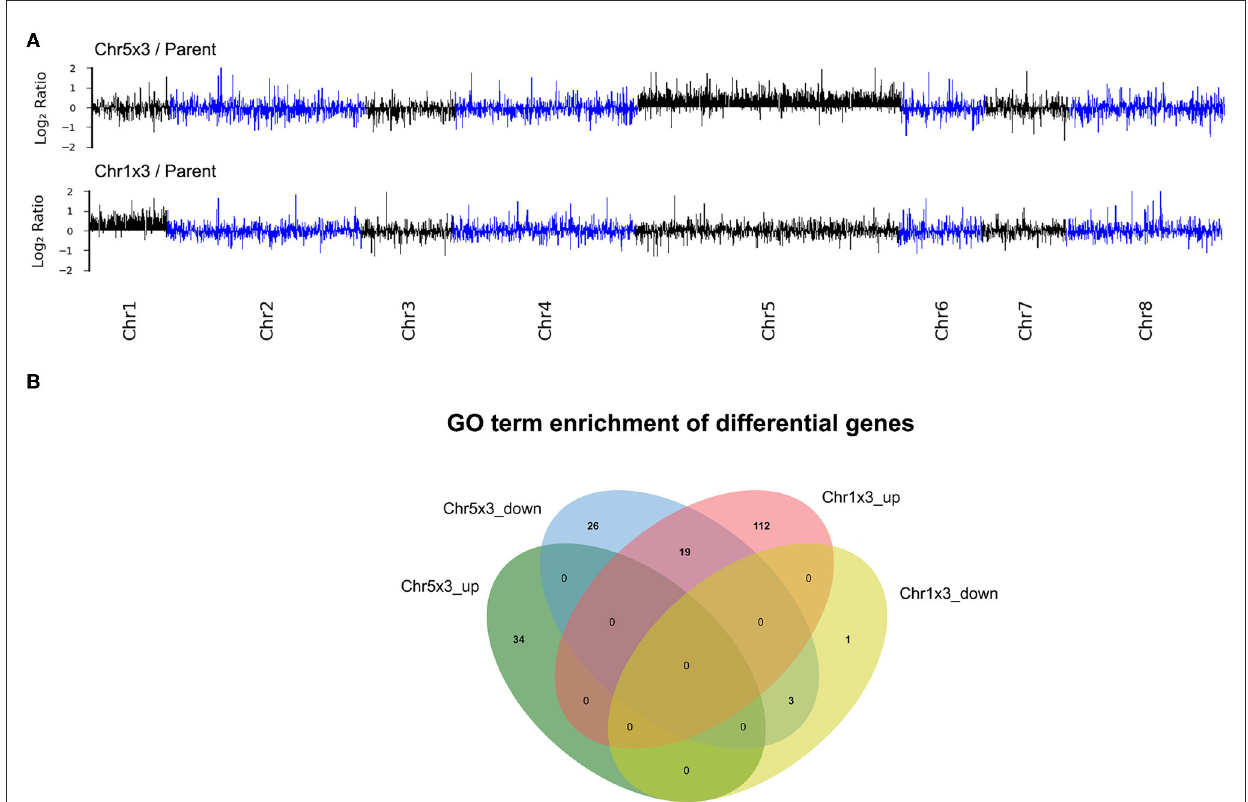
FIGURE5 Transcriptional consequences of aneuploidy. Transcriptomes of Chr5x3 and Chr1x3 adaptors were compared to the diploid parent. Log 2 ratios were plotted as a function of gene position on the chromosomes (A) . Differential genes were analyzed for gene ontology (GO) enrichments. Lists of up and downregulated genes were analyzed separately. Venn diagram was used to illustrate the difference and commonality of the GO enrichments in genes upregulated in Chr1x3 (Chr1x3_up) and Chr5x3 (Chr5x3_up), as well as genes downregulated in Chr1x3 (Chr1x3_down) and Chr5x3 (Chr5x3_down) as compared to parent (B)